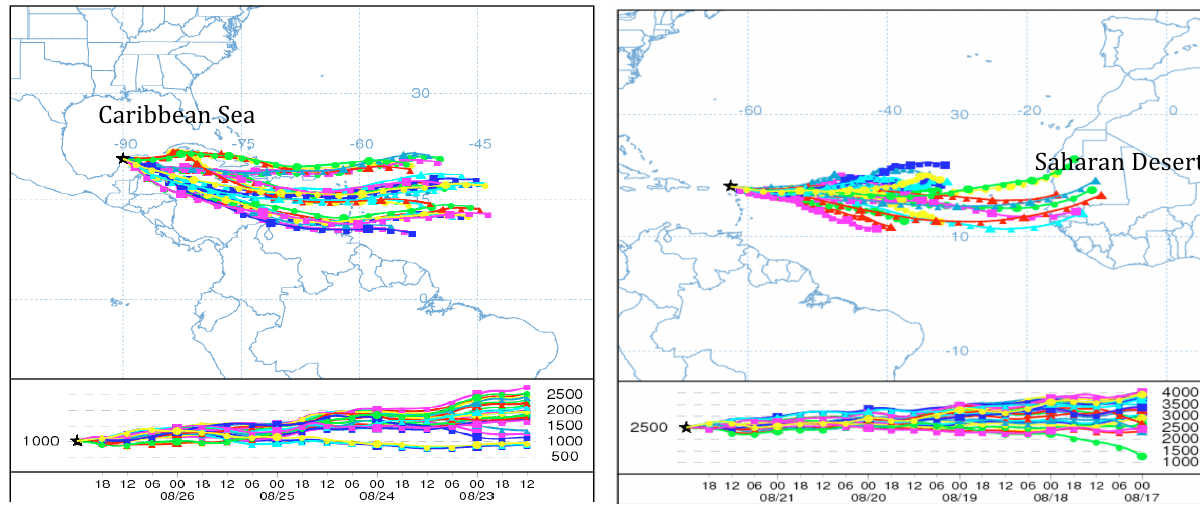
Fig. 11. Back trajectory ensemble of Sahara dust for Caribbean Sea from 27 August to 22 August in 2006 (left) and from 22 August to 17 August in 2006 (right) using HYSPLIT model for altitude 1000m (left) and 2500m (right). The horizontal trajectory components (top) and the vertical components (bottom) are shown in the figures. We chose two back trajectory ensemble runs because the maximum ensemble run time of HYSPLIT is 120h.